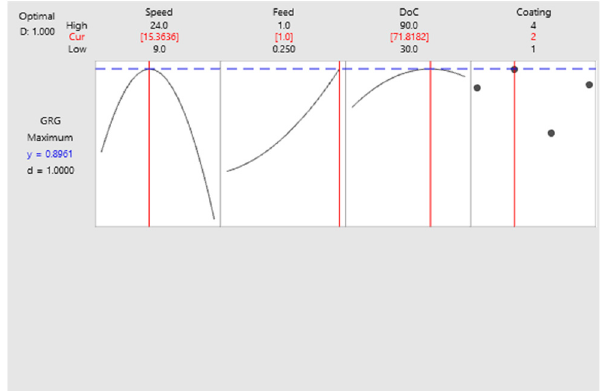
Figure 8. Response surface optimization of GRG . * 1 = nACo, 2 = AlTiN, 3 = TiSiN, 4 = uncoated.